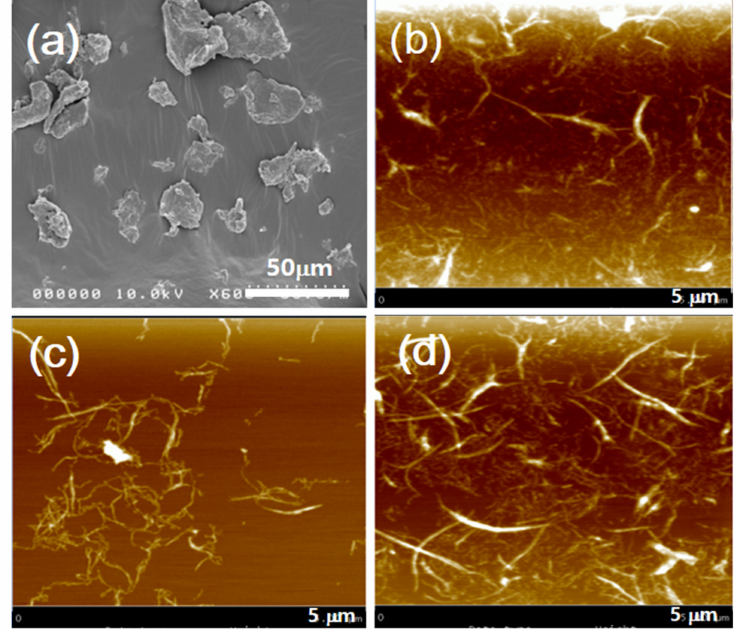
Figure 2. E ff ect of ACC passes on the viscosity of ChNF suspension: ( a ) viscosity change with time, and ( b ) viscosity change with ACC pass number.